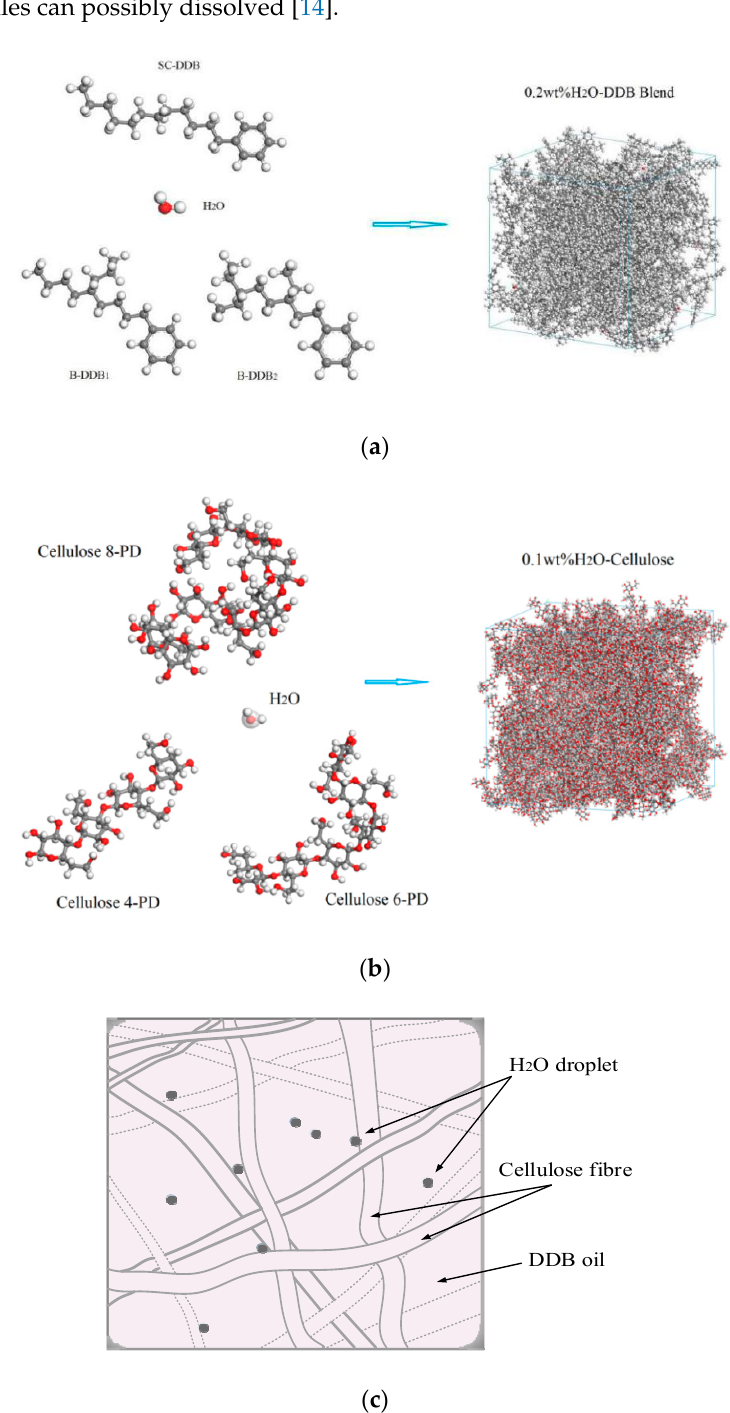
Figure 1. Molecular models for amorphous multi-molecules mixed systems constructed from solute H 2 O with ( a ) three types of DDB molecule and ( b ) three pieces of cellulose molecules in 4, 6, and 8 polymerization degrees. Gray, white, and red balls represent carbon, hydrogen, and oxygen atoms respectively; ( c ) Schematic microstructure of porous intervals between cellulose fibers with H 2 O molecule cluster (water impurity) absorbed on them in